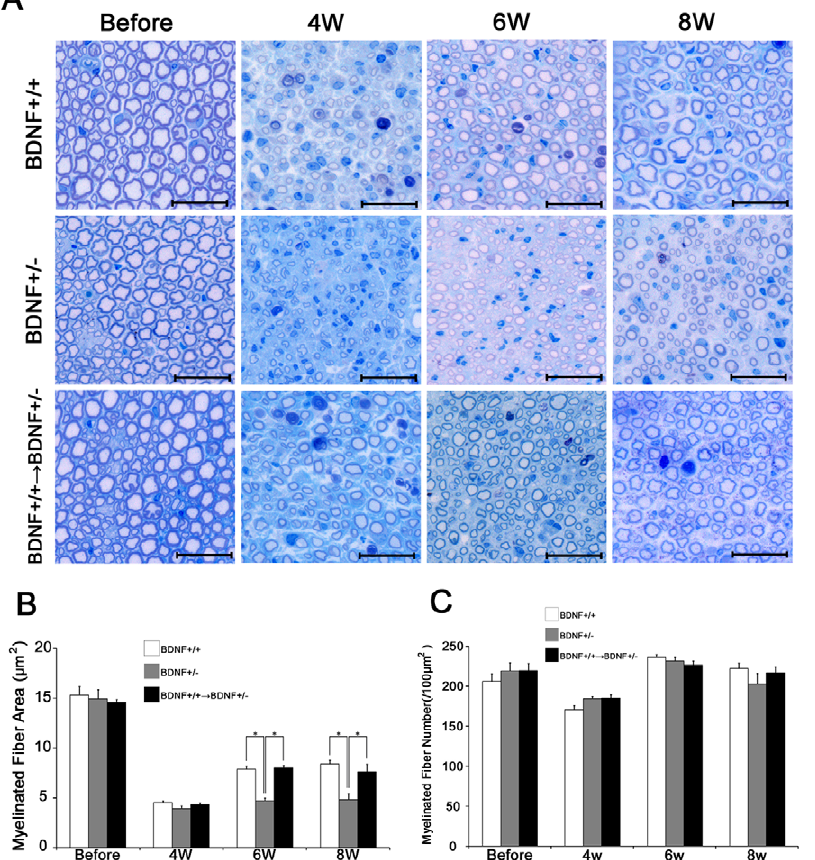
Figure 4. Histological changes of sciatic nerve in BDNF + / 2 . A ) Nerve fiber regeneration was examined in BDNF + / + littermates, BDNF + / 2 , and BDNF + / + R BDNF + / 2 . (n=5 per genotype). Bar indicates 20 m m. B ) Myelinated fiber area in each group. (n=5 per each groups). C ) Number of myelinated fibers in each group. (n=5 per each groups). **p , 0.05.